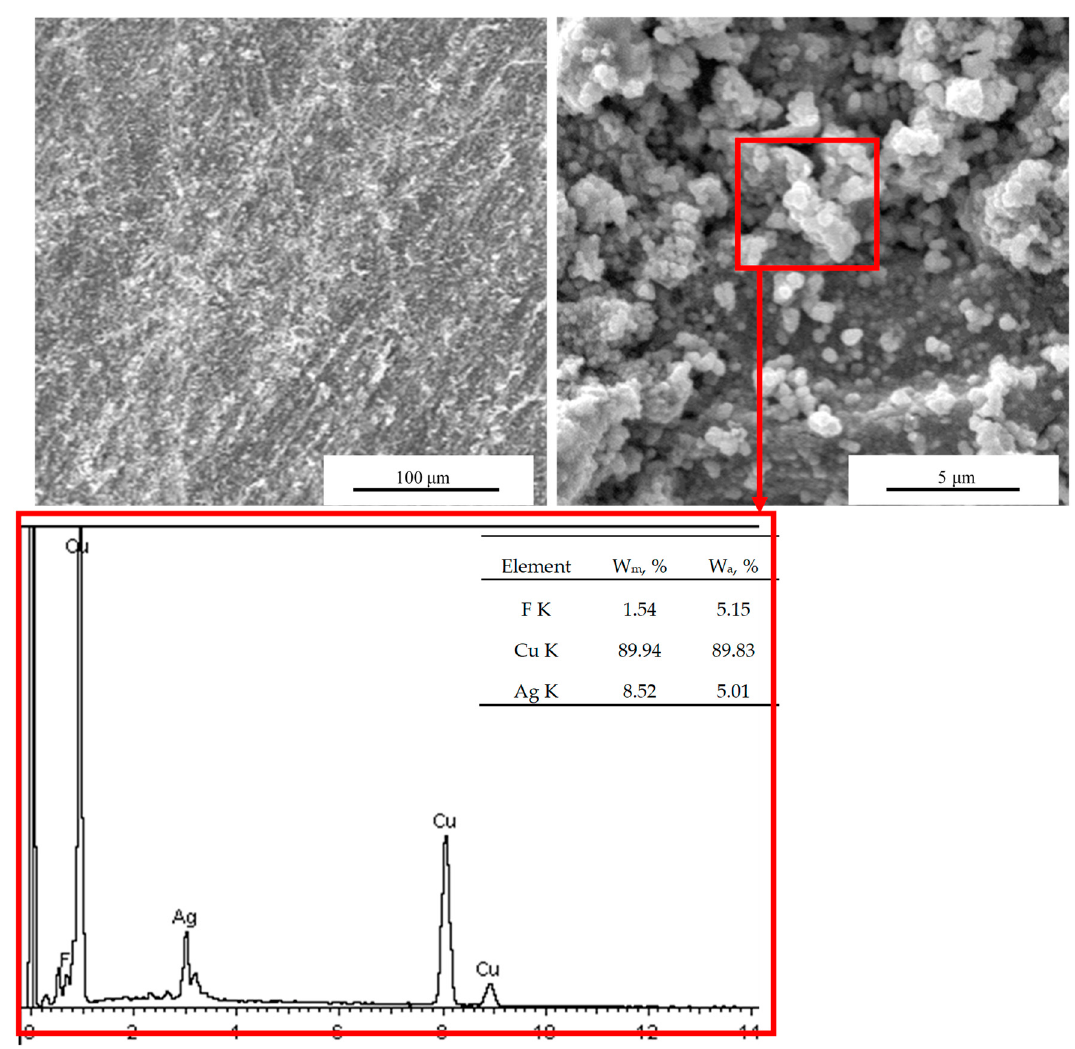
Figure 1. SEM micrographs and EDS spectra of the sample L4.